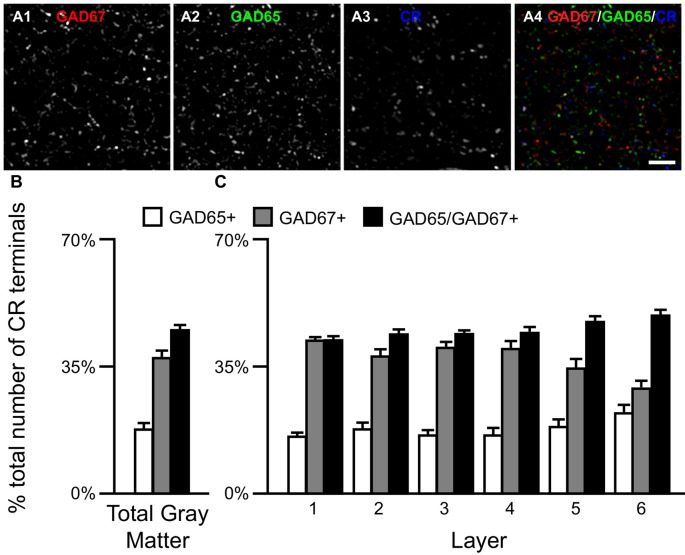
The proportion of three CR/GAD+ terminal subpopulations differs across cortical layers. (A) Projection image (7 z-planes separated by 0.25 μm) of a human PFC tissue section immunolabeled for CR, vGAT (not shown), GAD65 and GAD67. Gray scale images (A1–A3) are single channel images of the multichannel image (A4) and are representative of the immunohistochemistry labeling. Scale bar = 5 μm. (B,C) Bar graphs showing the relative proportions of vGAT/CR+ terminals in PFC that were GAD65+, GAD67+, or GAD65/GAD67+. Error bars = SEM.